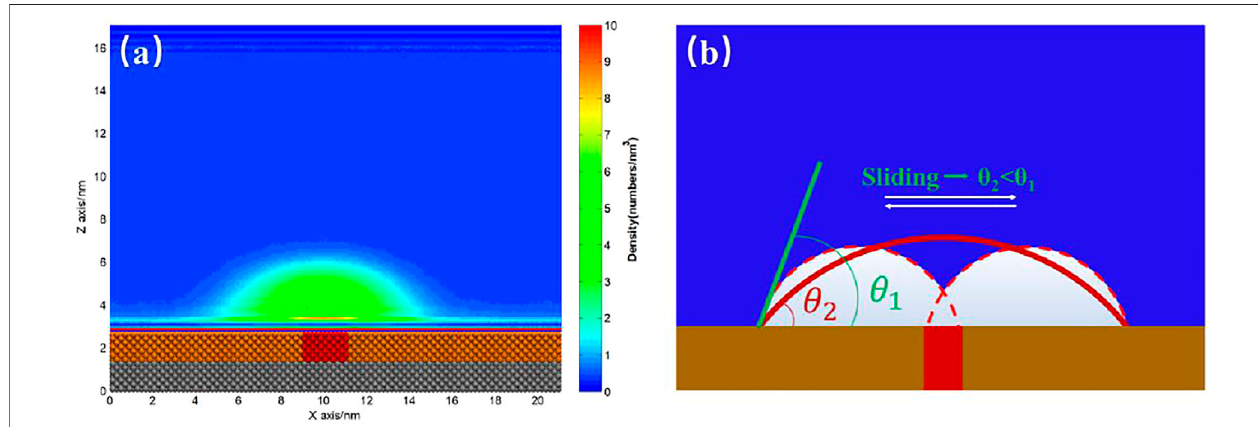
FIGURE9|(A) Time-averageddensitydistributionmapofgasparticles. (B) SketchofINBpinnedbythemorehydrophobicsiteonthehydrophobicsubstrate.The yellow substrate represents the hydrophobic solid, and the red site represents the more hydrophobic solid. The white spherical cap represents the actual INB, and the red solid line represents the apparent INB we usually used to calculate contact angle.